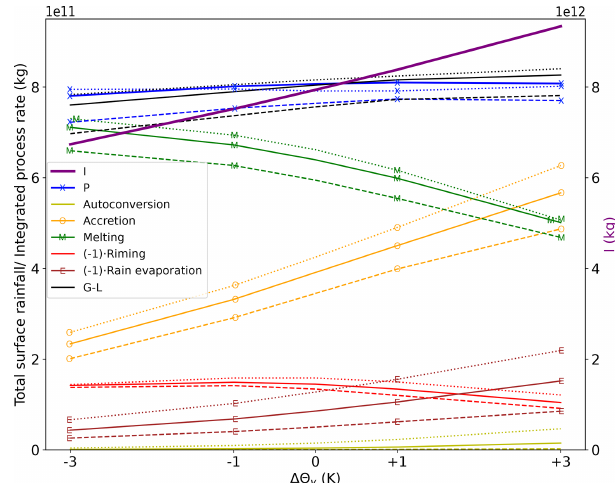
Figure 8. Processes contributing to rain generation (autoconver- sion, accretion and melting) and removal of rain (rain evaporation, riming onto graupel) for four temperature perturbations at three dif- ferent CCN concentrations, n CCN = 200cm − 3 (dotted), 500cm − 3 (solid) and 1500cm − 3 (dashed). The values are averaged over 16h and integrated inside LAKEDISTR, as defined in Sect. 2.3. Black lines show the sum of the rain generation processes minus the sum of the removal processes ( G − L ). Blue lines show the 16h rainfall total P . The purple line shows the integrated water vapour inflow I for all CCN concentrations. Values of I are shown on the right axis.